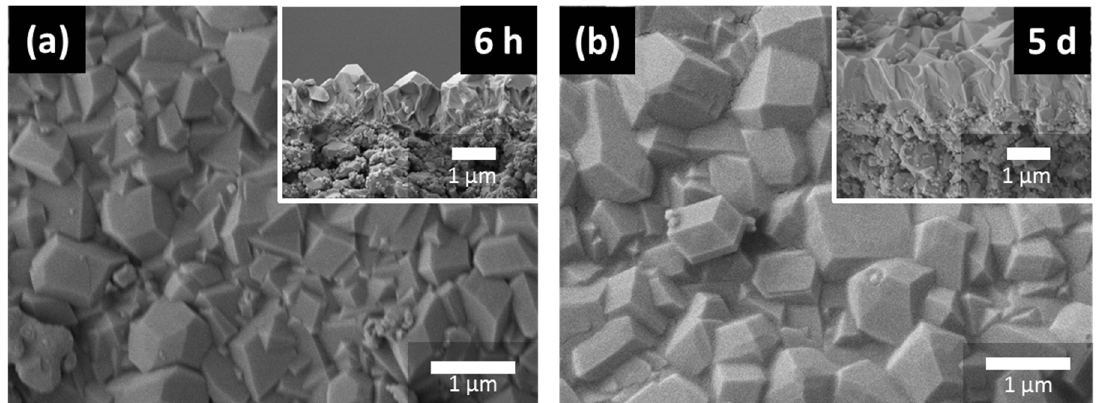
Figure 3. SEMs of ZIF-8 membranes grown on the bore side of alumina tubes at secondary-growth times of 6 h ( a ) and 5 days ( b ). Cross-sectional images are shown as insets.